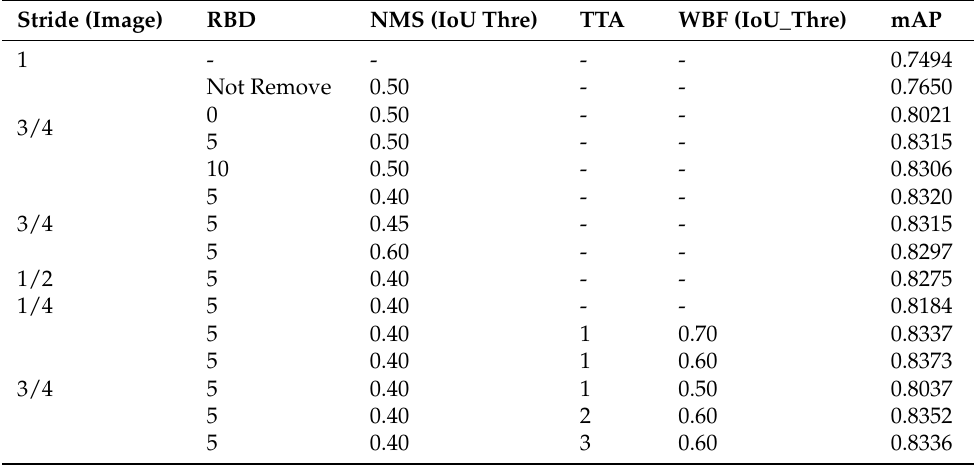
Table 4. Hyperparameter selection in software